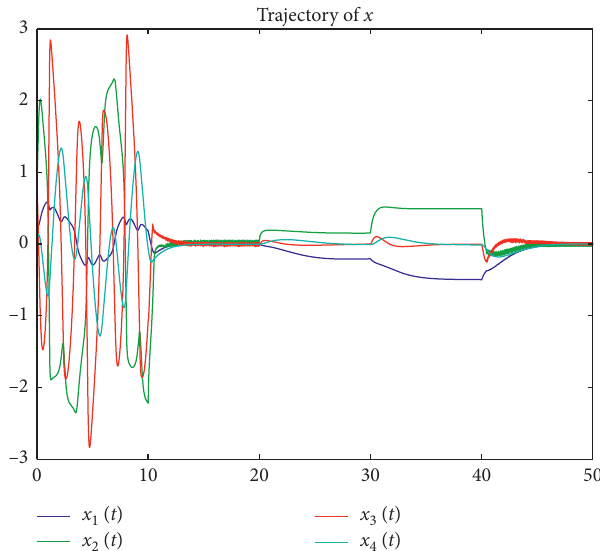
Figure 3: Trajectory of the state (this figure shows the trajectory of the dynamical system (22) with the given fault in (26) and (27) by using the proposed learning-based control in